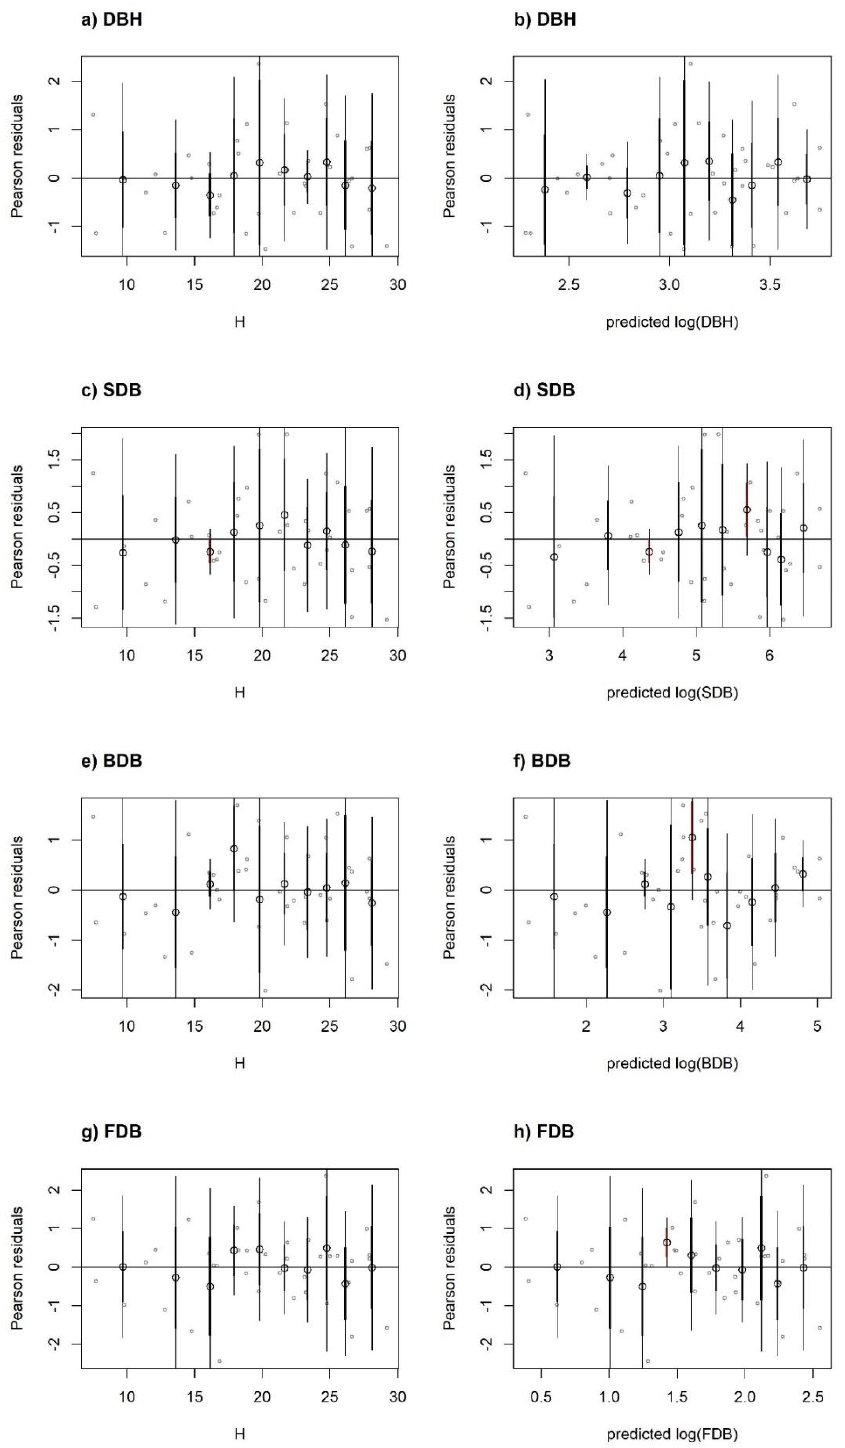
Figure 4. Residual plots for individual mixed-effect model for diameter at breast height (DBH, ( a ), ( b )), stem dry biomass (SDB, ( c ), ( d )), branches dry biomass (BDB, ( e ), ( f )) and foliage dry biomass (FDB, ( g ), ( h )) as dependent variables with height as independent variable (second approach). Grey dots define the models’ Pearson residuals. Large black dots show the means of residuals in 10 classes of height (H, ( a ), ( c ), ( e ), ( f )), and predicted values of dependent variables (( b ), ( d) , ( f) , ( h) ). The thin vertical lines show the confidence interval of individual observations (mean ± 1.96 SD). The thick vertical lines (inside black dots) show the 95% confidence interval of class mean.